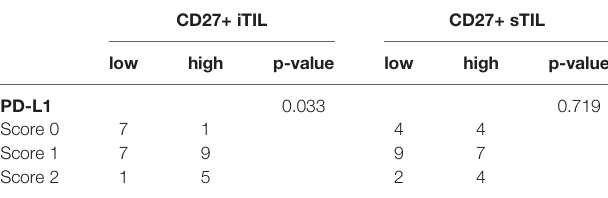
TABLE 4 | Correlation between CD27-positive TIL and PD-L1